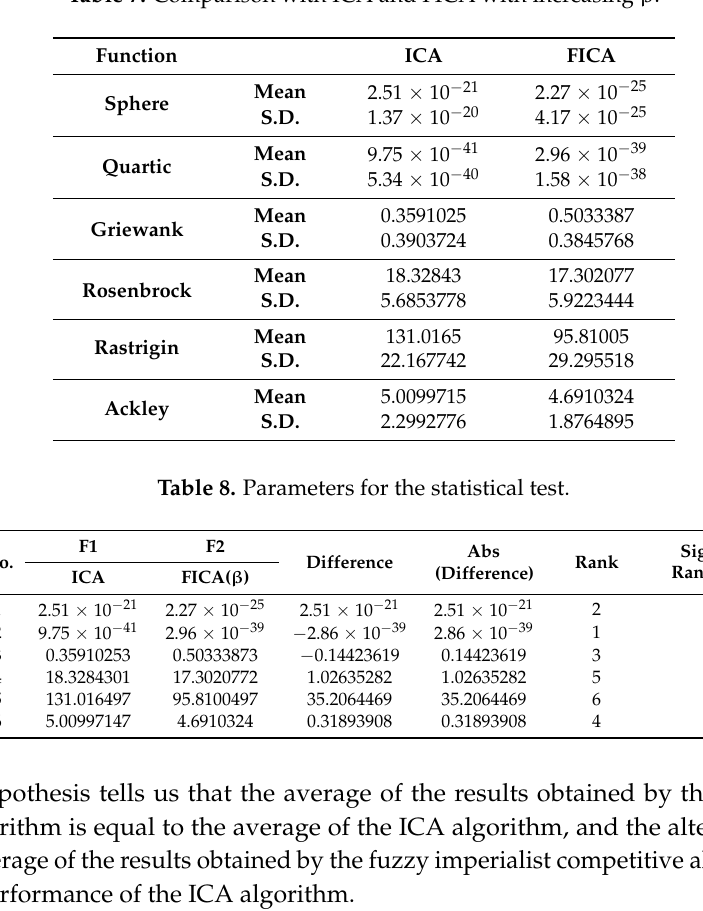
Table 7. Comparison with ICA and FICA with increasing β .